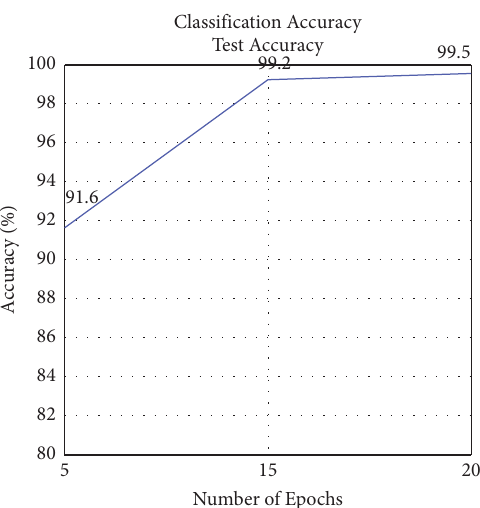
Figure 12: Classifcation accuracy of ResNet using Adam